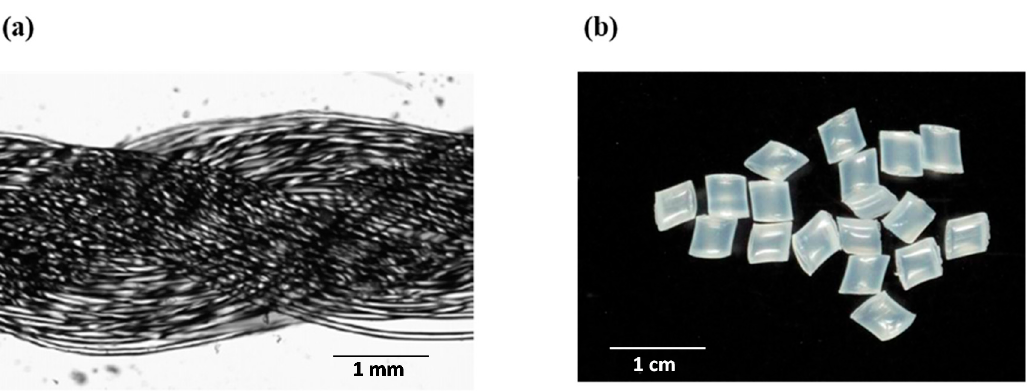
Figure 3. Nylon 6/6 threads (( a ), shot with Olympus CX31) and pellets (( b ), shot with UV transilluminator, Cleaver Scientific Ltd., Warwickshire, UK).